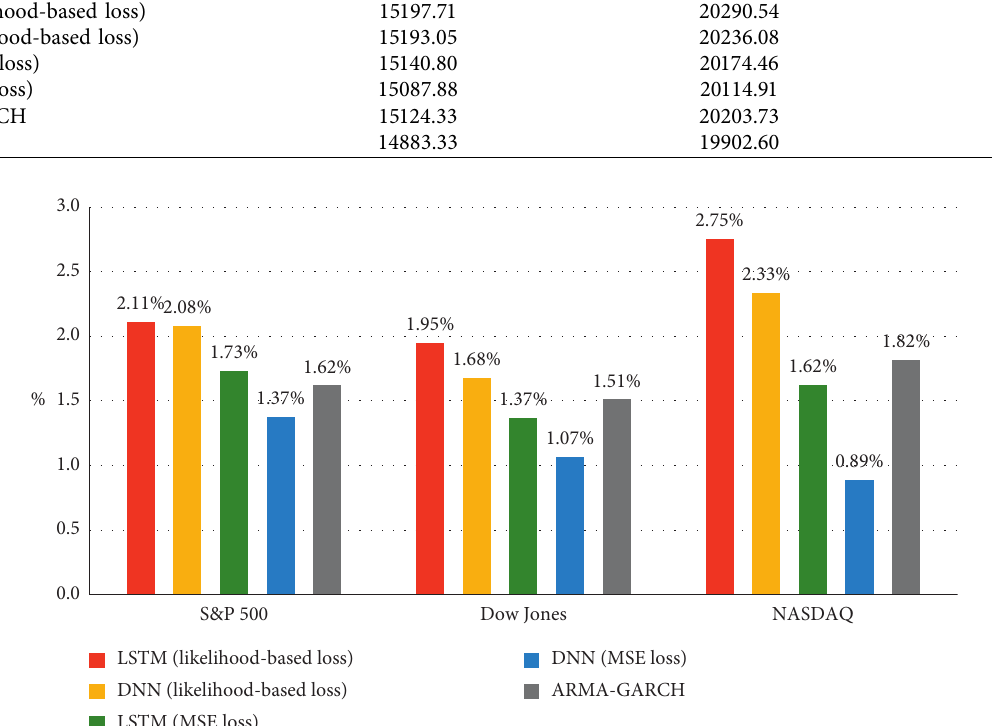
Figure 10: Log-likelihood improvements upon the simple method when the test set is